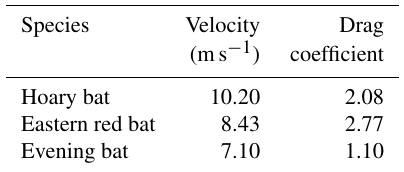
Figure 7. Measurements and modeled time vs. fall velocity for drop test 1 of the hoary bat. Table 2. Drag coefficient computed from the terminal velocity as-